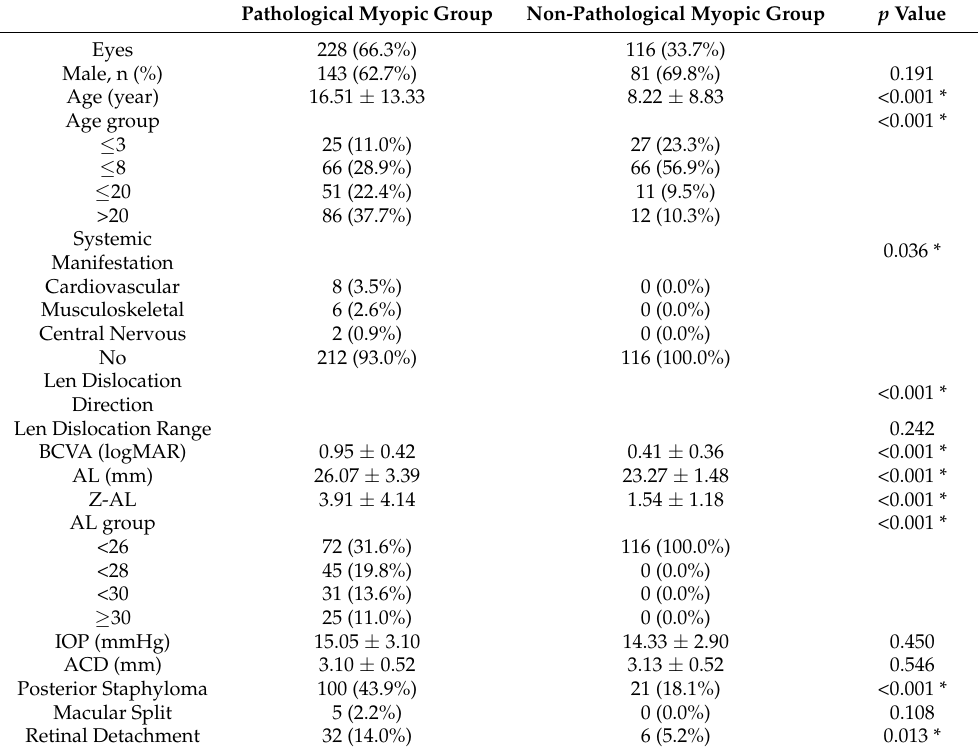
Table 2. Baseline characteristics for MFS in the Pathological myopic group and the Non-pathological myopic group.